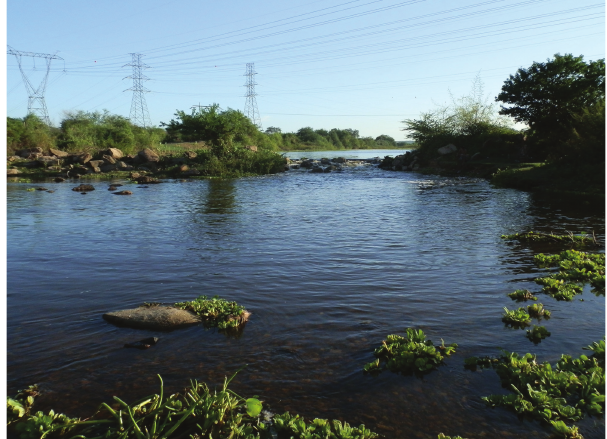
Fig. 9. The putative type locality of Parotocinclus spilurus , Brazil, Ceará, Icó, rio Salgado, rio Jaguaribe